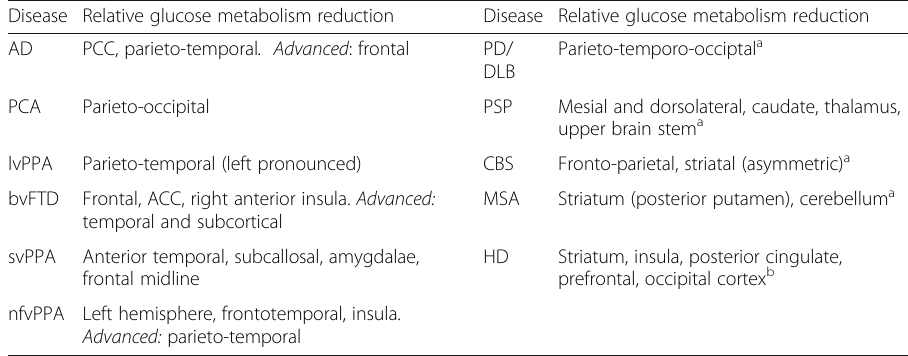
Table 3 Summary of typical hypometabolism patterns in [ 18 F] FDG PET in different neurodegenerative diseases Disease Relative glucose metabolism